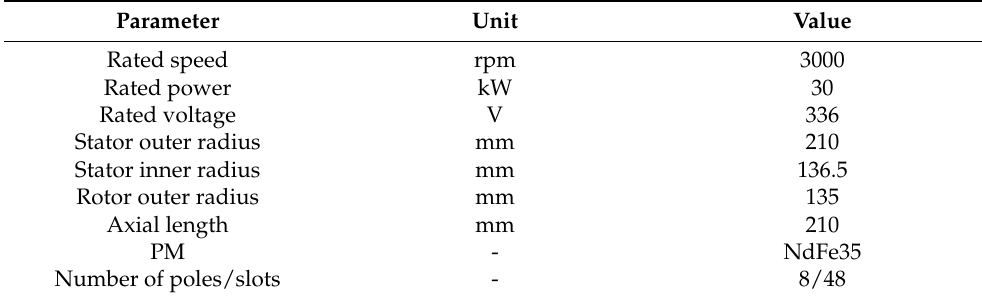
Table 1. Primary parameters of the IPMSM.